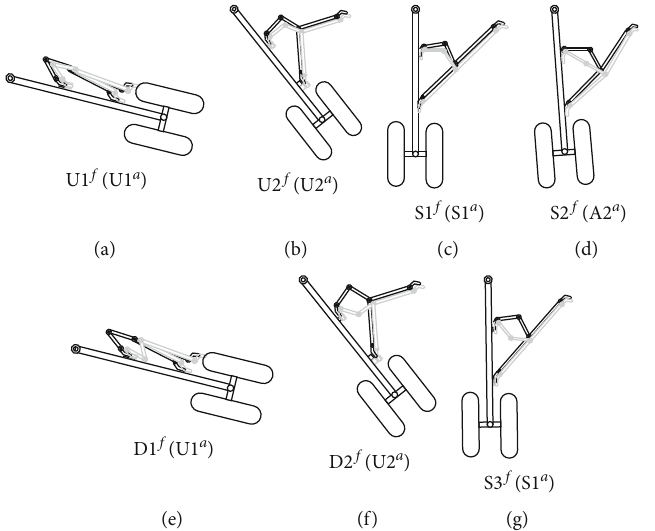
Figure 14: Sketches of DS mechanism motions: (a) U1 f (U1 a ); (b) U2 f (U2 a ); (c) S1 f (S1 a ); (d) S1 f (A2 a ); (e) D1 f (U1 a ); (f) D2 f (U2 a ); (g) S3 f (S1 a ).